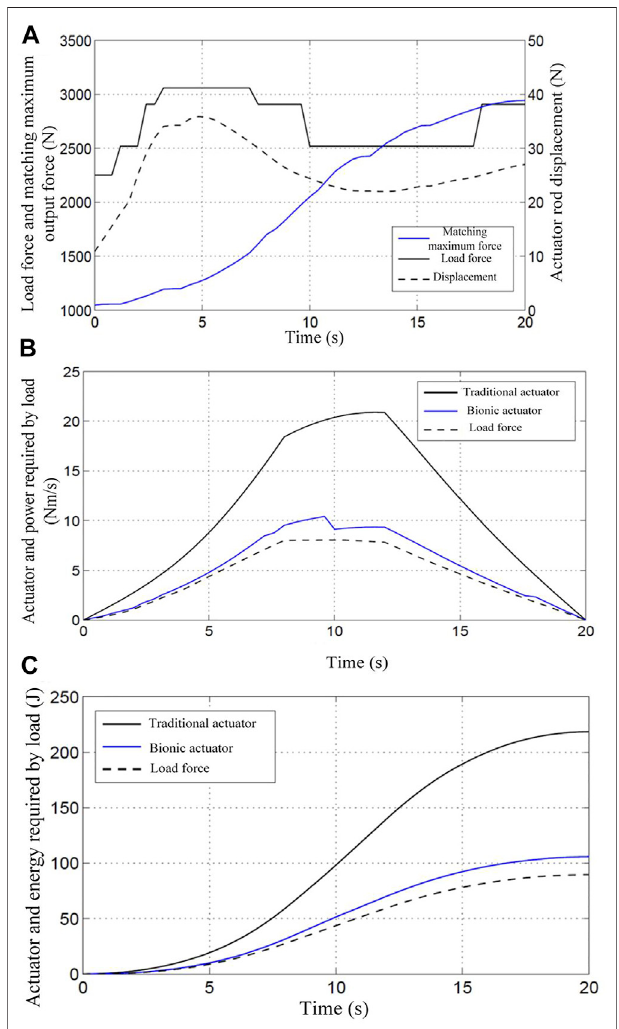
FIGURE9| Theresultsoftheexperimentunderaloadof15 kg (A) 15Kg load force matching; (B) 15Kg load power consumption curve; (C) 15Kg load energy consumption